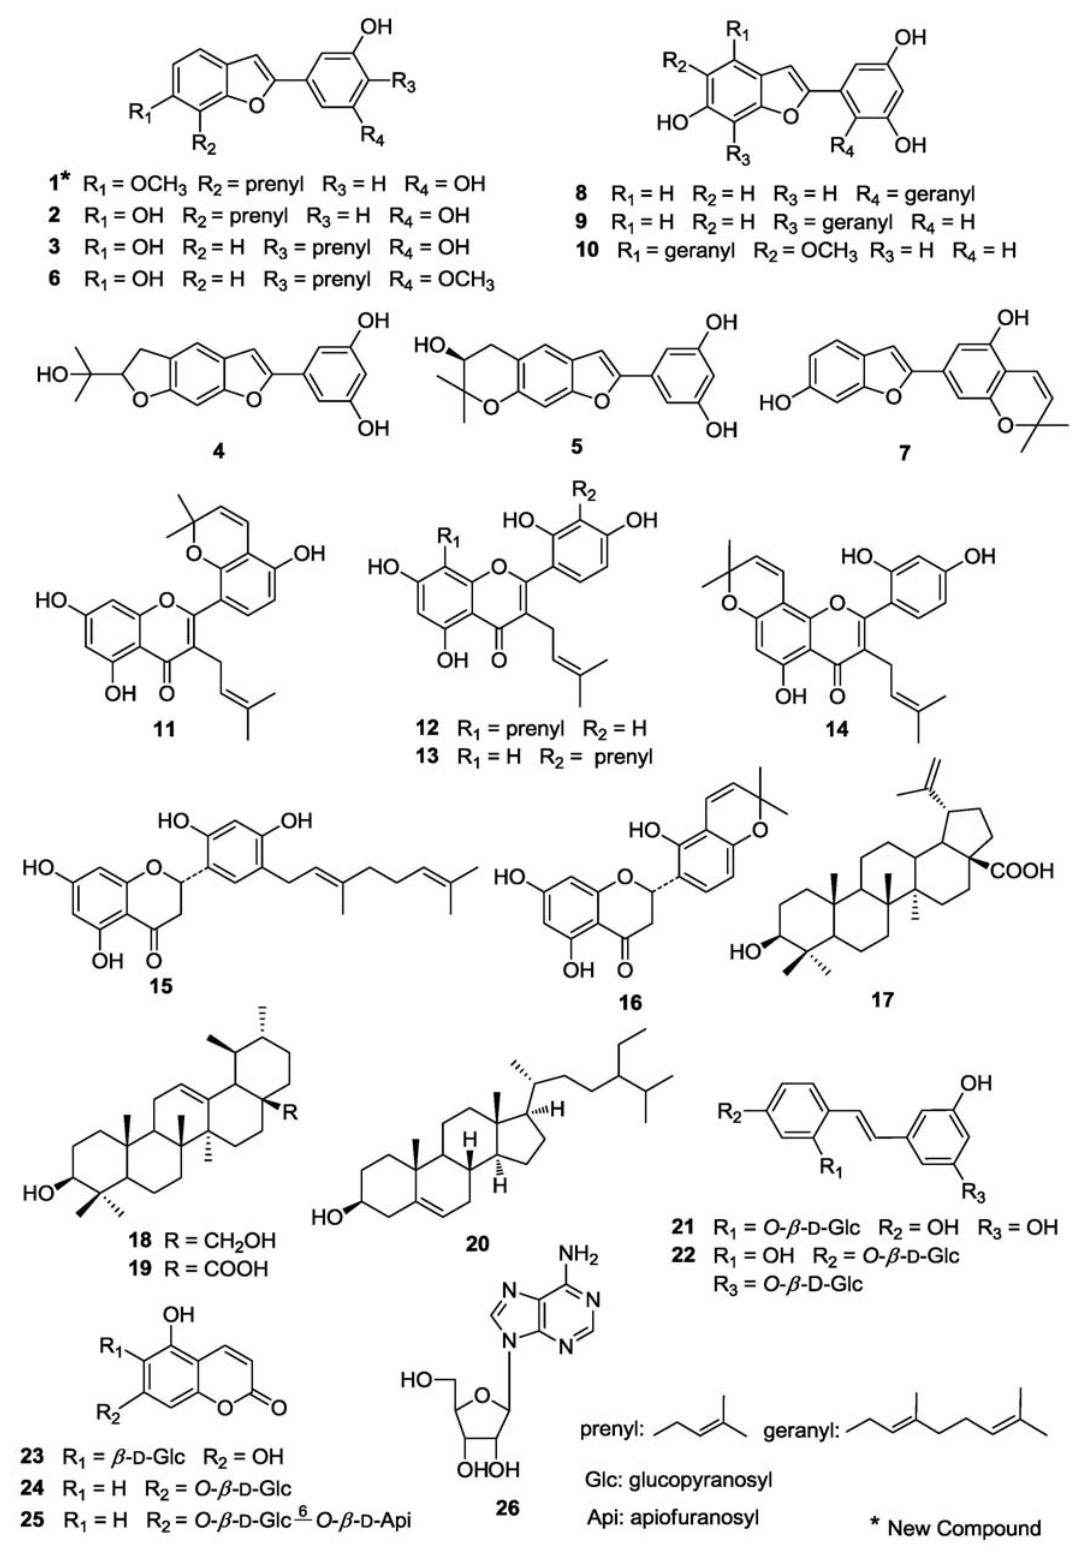
Figure 1. Structures of Compounds 1 –